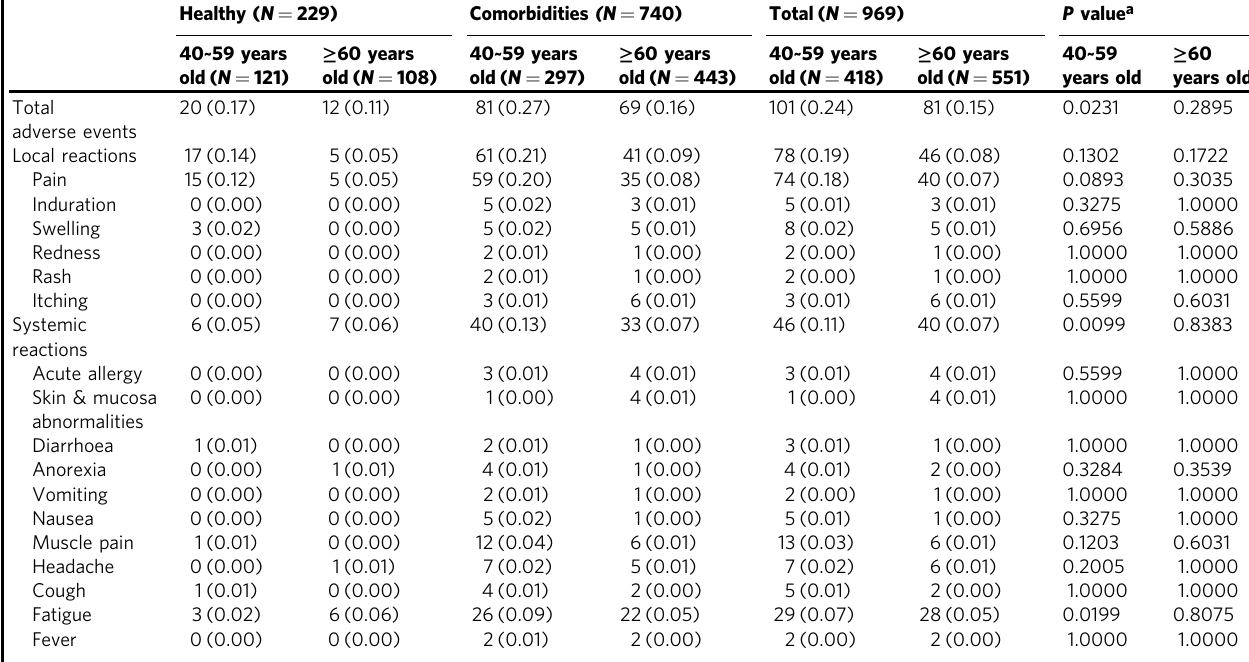
Table 2 Incidence of adverse events after vaccination in healthy group and comorbidities